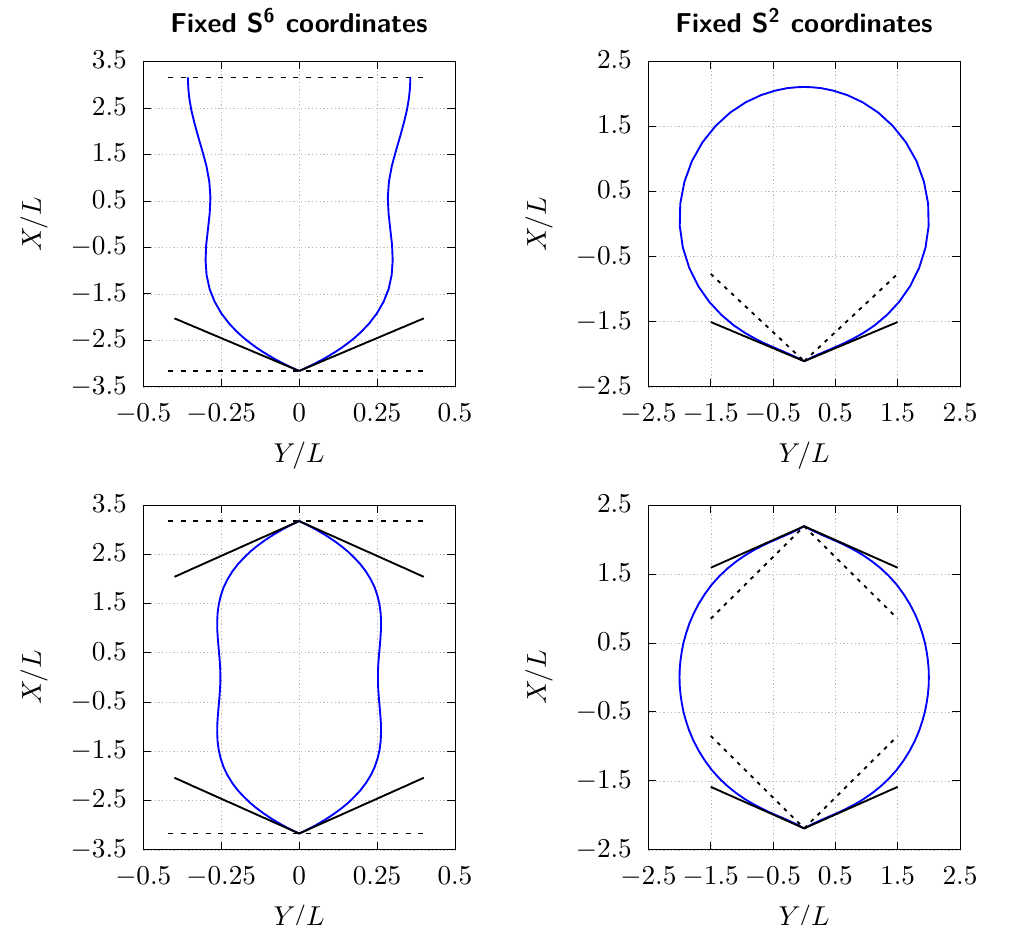
Figure 14. Embedding diagrams of the horizon for the ‘ = 1 (top) and ‘ = 2 + (bottom) lumpy black holes (blue line) in AdS 7 for the largest lumpiness parameter that we have reached. The 4 × S plots on the left correspond to fixed S 6 coordinates while the plots on the right correspond to fixed S 2 coordinates. The black lines correspond to the embeddings of the local cone that mediates the topology change transition. For fixed S 6 coordinates, the agreement between the cone model and the local horizon geometry is very good. For fixed S 2 coordinates, demanding that the cone model agrees with the local geometry suggests α = q − 2 + D = 31 . In these two plots the embeddings 4 4 dictated by the Ricci-flat cone are indicated with dashed lines. Clearly, the latter do not agree with our